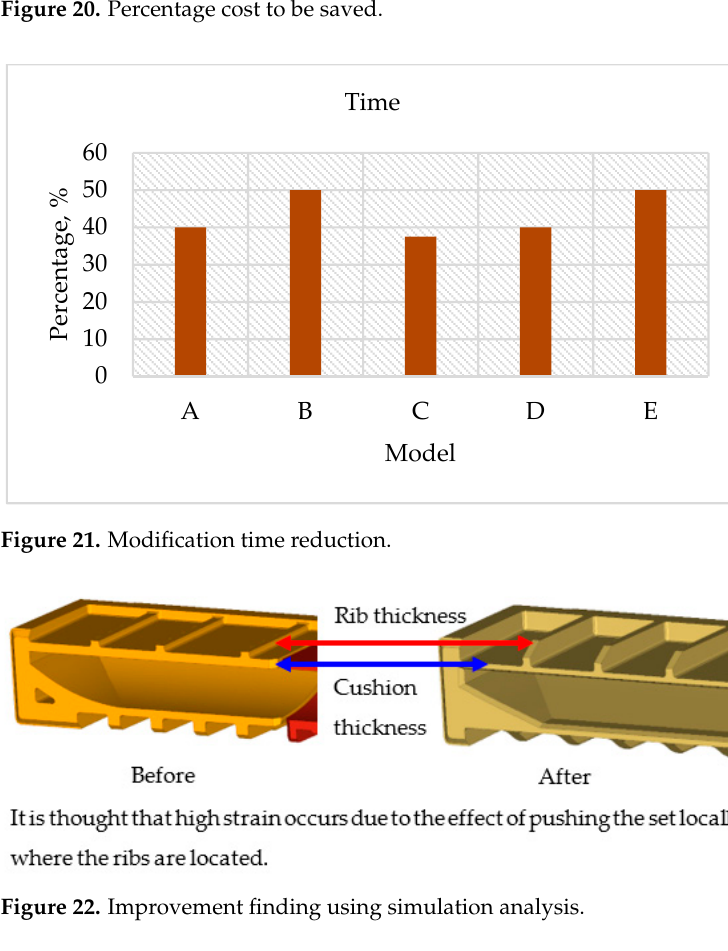
Figure 22. Improvement finding using simulation analysis.